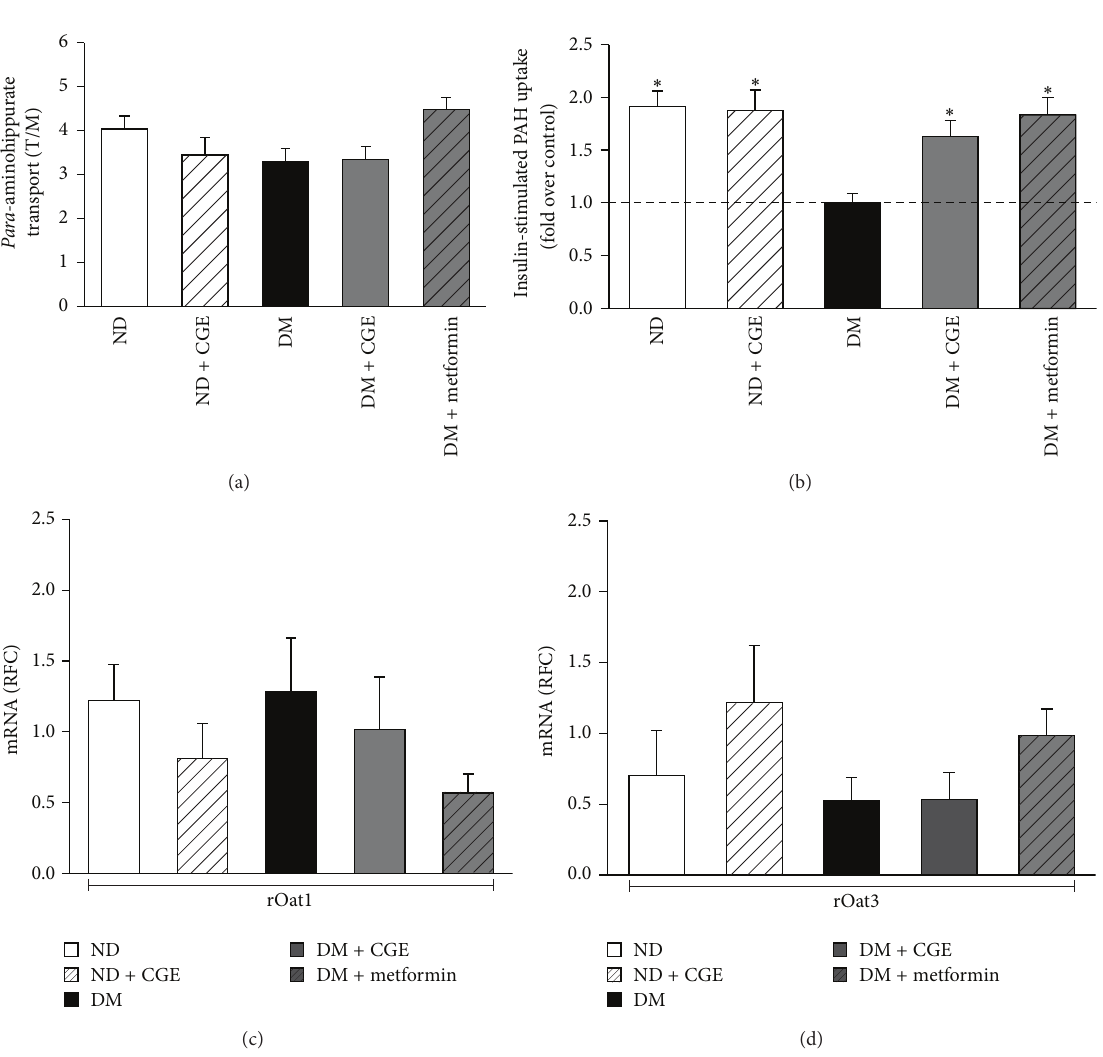
Figure4: Effects of Cladophora glomerata on PAH transportby rOat1and rOat3 and theirmRNAexpressions. (a)Ratrenal cortical slices were incubated for 30 min in the buffer containing 5 𝜇 M of [ 3 H]-PAH at room temperature. Data are expressed as tissue to medium ratios (T/M), that is, tissue content (DPM/mg) ÷ medium (DPM/ 𝜇 L), and represented as mean ± SD. Each experiment was performed from separate animals and at least 5 renal slices were used in each condition ( 𝑛 = 6–8). (b) Rat renal cortical slices were preincubated for 30 min in the presence or absence of 30 𝜇 g/mL of insulin and followed by incubation with classical substrate of organic anion transporters, 5 𝜇 M of [ 3 H]- PAH for 30min. Data are expressed as fold over control (without insulin). Each experiment was performed from separate sets of animals and 5 renal slices were used in each condition ( 𝑛 = 6 ). ∗ 𝑃 < 0.05 indicates significant differences from the slices incubated with buffer alone. (c) Rat Oat1 and (d) Rat Oat3 mRNA expressions in renal cortical tissues. Total RNAs were extracted from rat cortical tissues from each animal and rOat1 and 3 mRNA levels were measured using quantitative real-time PCR (qPCR). The data are expressed as mean ± SD and repeated from separate animals ( 𝑛 =